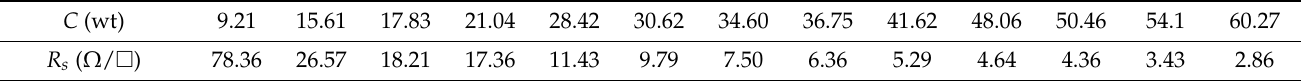
Table 2. Sheet resistance measurements as a function of nanocomposite concentration for a fixed amount of PEDOT:PSS (2.70 wt%) and varying amounts of